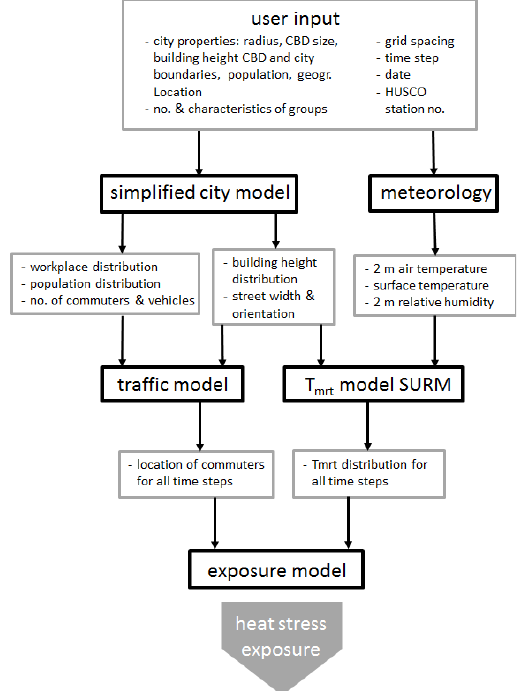
Figure 1. Schematic diagram of the model components (black boxes), inputs, and outputs (gray